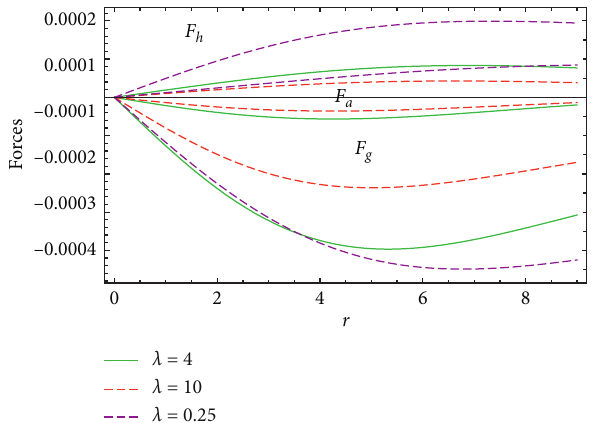
Figure 10: Graphical behavior of three forces, namely, F r for Vela X-1 under the values of parameters from F g , against Table 1 with λ � 0 . 25, 4, and 10.